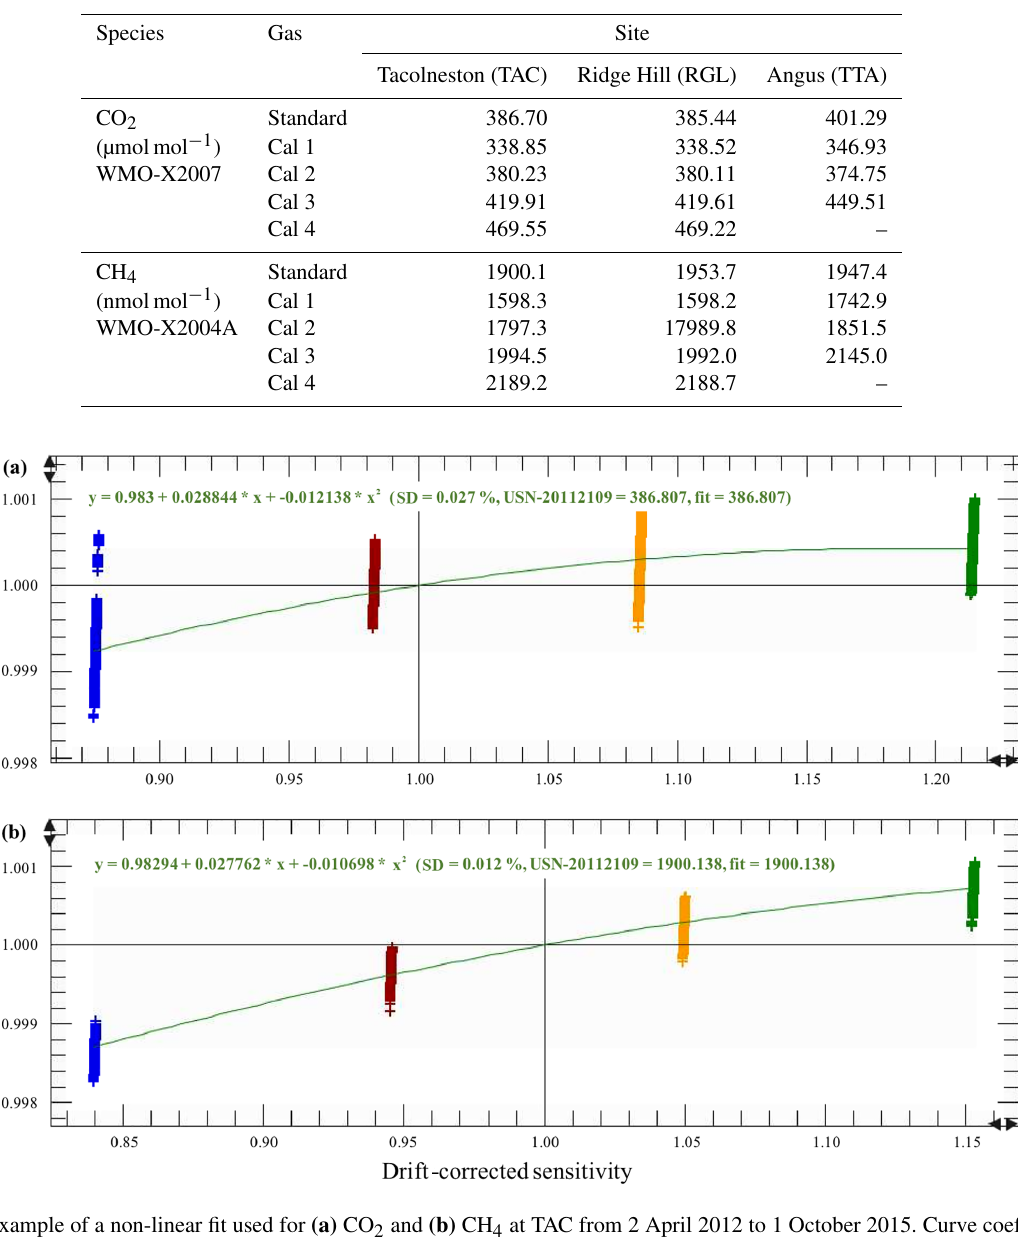
Table 6. Cavity ring-down spectrometry calibrant (cal) and standard gas mole fractions for CO 2 (µmolmol − 1 ) and CH 4 (nmolmol − 1 ) assigned by GasLab at MPI-BGC Jena for the UK DECC network.